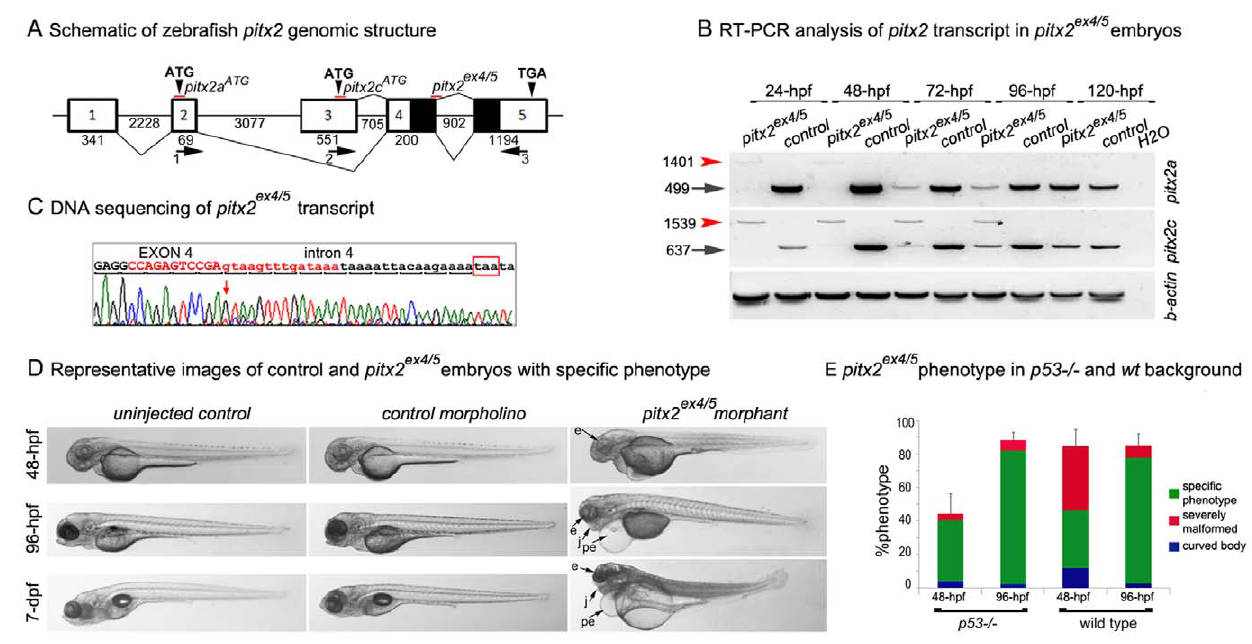
Figure 1. zebrafish pitx2 knockdown and associated phenotype. A . Schematic drawing of pitx2 genomic structure. Exons are shown as numbered boxes, sizes are indicated at the top (for exons) or at the bottom (for introns). The positions of primers to amplify pitx2 transcripts are shown and numbered 1–3; primers 1 and 3 are used for pitx2a and 2 and 3 for pitx2c . The position of antisense morpholino oligonucleotides, pitx2a ATG , pitx2c ATG and pitx2 ex4/5sp , are shown with red lines. B . RT-PCR of pitx2 expression in pitx2 ex4/5 morphants. Please note a complete absence of normal pitx2 transcripts (indicated with black arrows) and the presence of an abnormal large PCR product (indicated with red arrowheads) in mRNA extracted from pitx2 ex4/5 embryos at 24–48-hpf, the presence of both normal (diminished) and abnormal products at 72–96-hpf pitx2 ex4/5 , and normal levels of pitx2 by 120-hpf due to weakening of morpholino effects. C . DNA sequencing of the abnormal PCR product observed in pitx2 ex4/5 morphant embryos identified the presence of the 902-bp intron 4 in the pitx2 ex4/5 transcript consistent with aberrant splicing (forward sequence is shown and the beginning of the intron is indicated with a red arrow; exon 4 sequence is shown in upper case while intron 4 is in lower case letters; the exon- intron junction sequence corresponding to the pitx2 ex4/5 antisense oligomer is indicated in red). Therefore, the pitx2 ex4/5 protein is predicted to contain partial pitx2 sequence (lacking amino acids encoded by exon 5) followed by 10 erroneous amino acids ( pitx2 ex4/5 stop codon is indicated with red box). D . Representative images of pitx2 ex4/5 morphants, control morpholino-injected embryos and larvae developed from uninjected eggs at 48- hpf, 96-hpf and 7-dpf. E . Bar graph showing the distribution of observed embryonic phenotypes following pitx2 ex4/5 morpholino injections into p53 2 / 2 and wild-type zebrafish eggs. e- eye, j- jaw, pe- pericardial